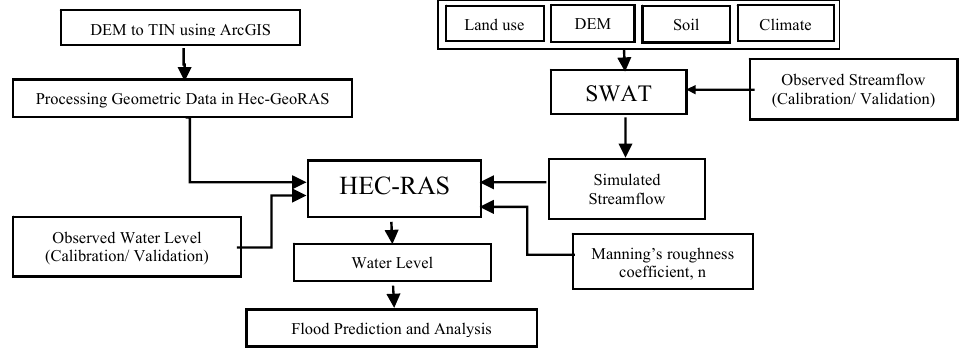
Figure 1. Schematic of data and models for flood prediction and analysis.